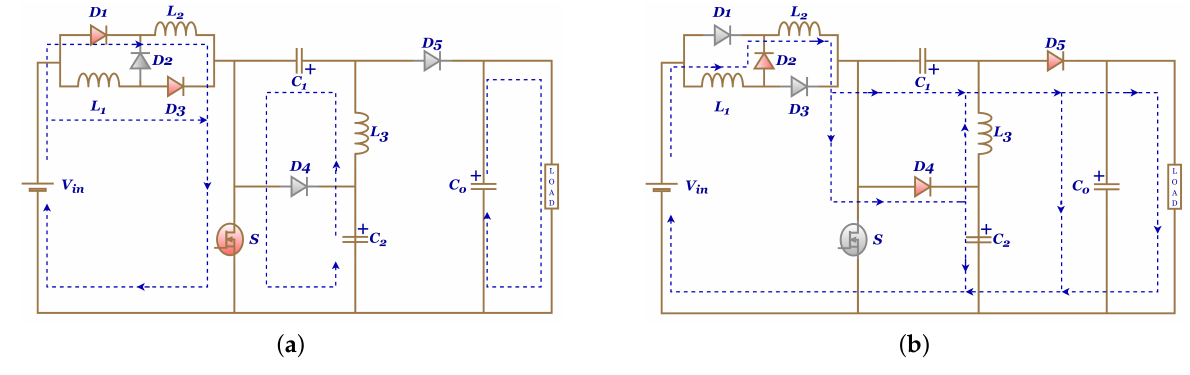
Figure 24. 3rd M-SEPIC operations ( a ) S closed ( b ) S